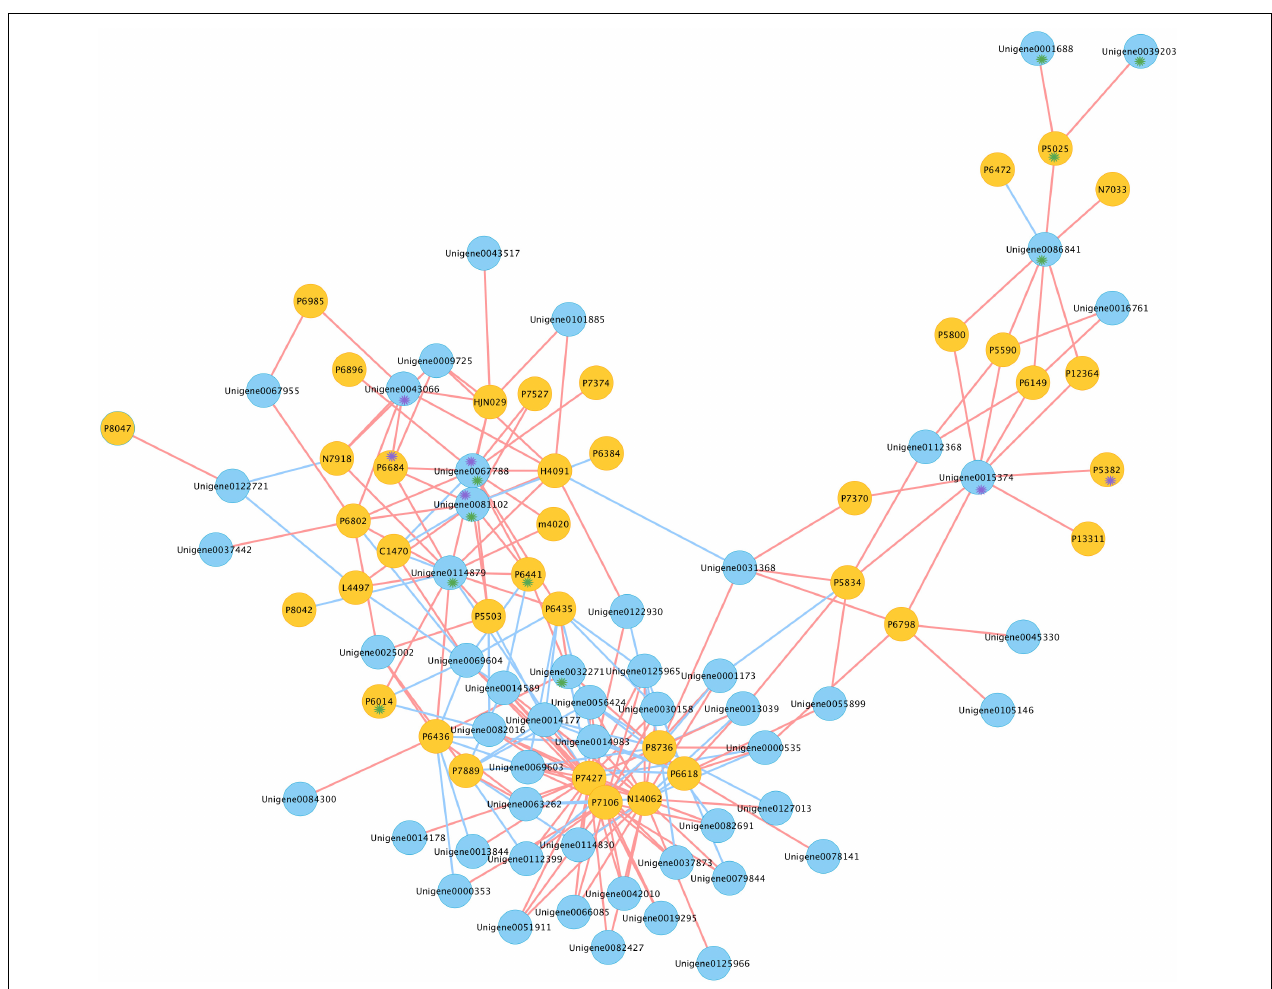
FIGURE 6 | Co-expression network of candidates CYP s and triterpenes in G. longipes. Blue nodes represented genes, yellow nodes represented triterpenes, red edges presented positive correlation, blue edges presented negative correlation. Compounds marked with purple ∗ had oxidization at C-19, unigene marked with purple ∗ possibly catalyzed oxidization at C-19; compounds marked in green ∗ had hydroxylation at C-2, unigene marked with green ∗ possibly catalyzed hydroxylation at